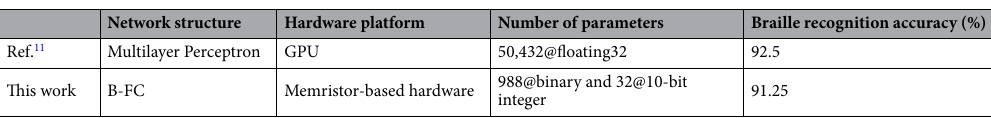
Table 1. Comparison between a previous work reported in the literature and this